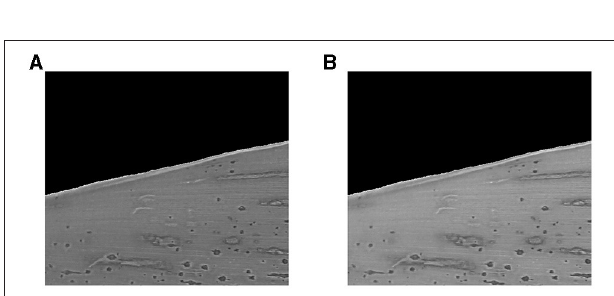
FIGURE 3 | Normalized grayscale images Q using the (A) average method and (B) weighting